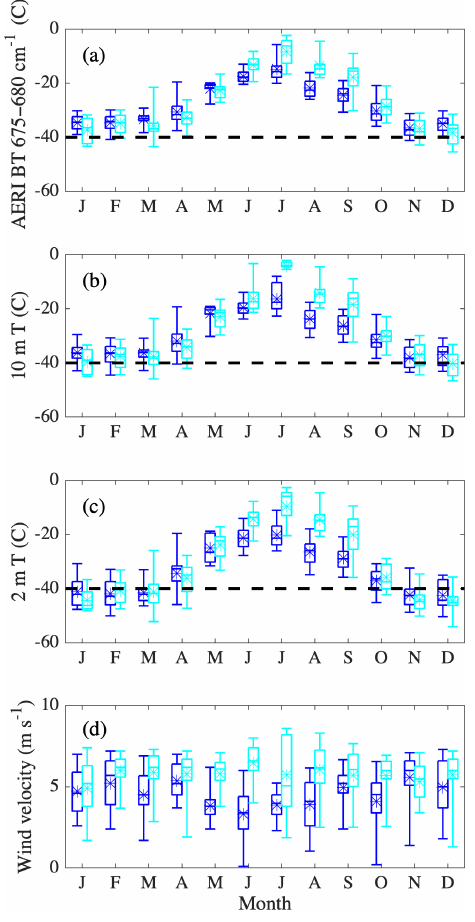
Figure 12. Box and whisker plots ( ∗ = mean, boxes are 25th, 50th, and 75th percentiles, whiskers are 5th and 95th percentiles) for each month for the ice fog category (cyan) and liquid fogs (blue); (a) AERI 675–680cm − 1 brightness temperatures (BT), (b) 10m air and (c) 2m air temperature; Panel (d) shows wind velocity at